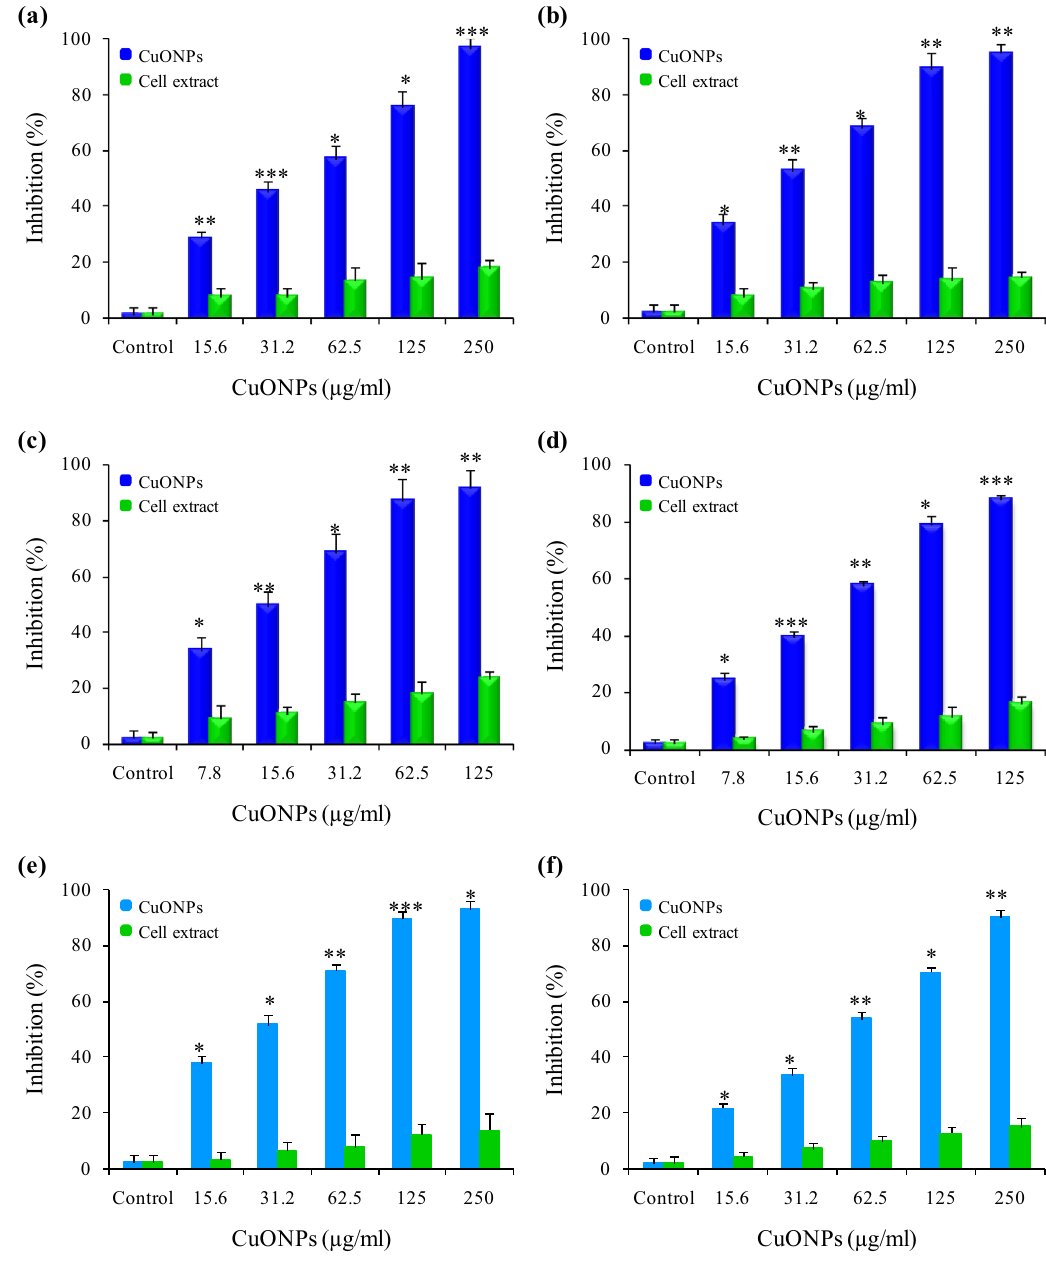
Figure 4. The inhibitory effect of Phormidium sp . derived CuONPs and cell extract on; ( a ) E. coli ; ( b ) K. pneumonia ; ( c ) B. cereus ; ( d ) S. aureus ; ( e ) C. albicans and ( f ) C. glabrata . Experiments were performed in triplicates; bars represent the mean of values and error bars represent mean ± SD (* P <